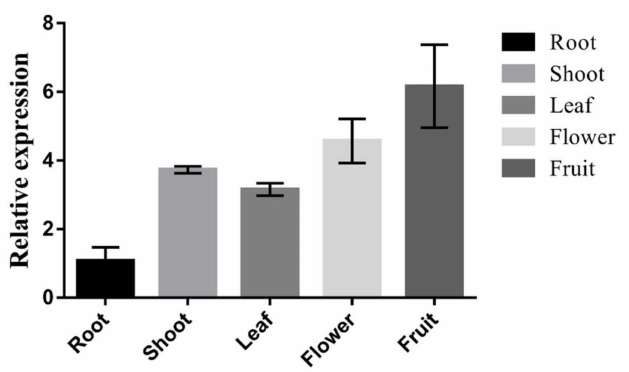
Figure 7. Expression levels of SlCOMT1 in di ff erent tomato tissues.